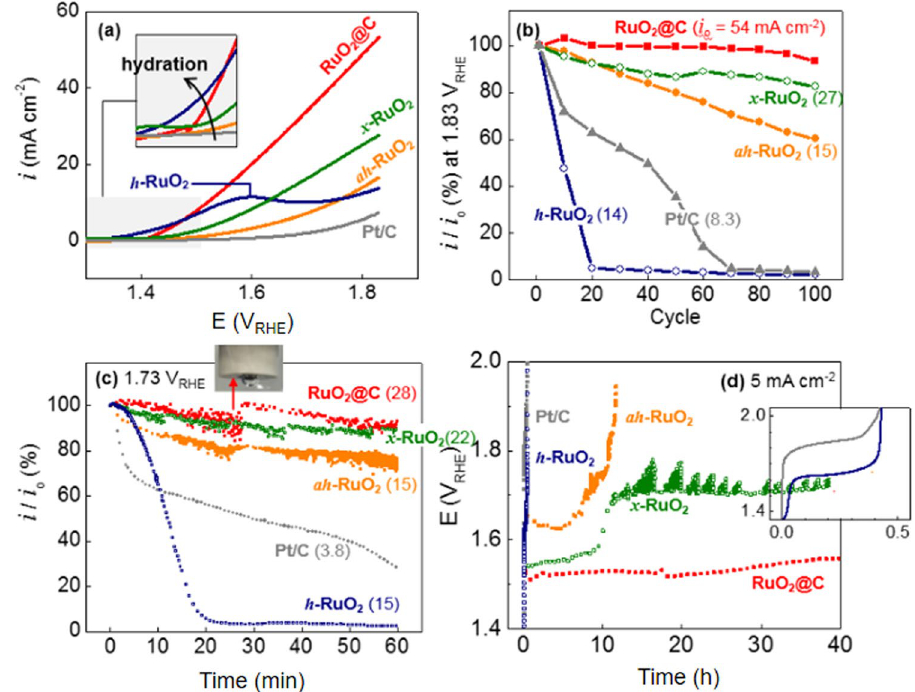
Figure 4. OER in N 2 -saturated 0.1 M KOH (aq). ( a ) OER polarization curves at 1,600 rpm for the first potential sweep cycles at 10 mV s − 1 . ( b ) OER current retention at 1.83 V RHE during repeated cyclic voltammograms. ( c ) Chronoamperometric stability of OER at 1.73 V RHE for 60 min in 0.1 M KOH. The initial currents are indicated next to the names of the catalysts. ( d ) Chronopotentiometric stability of OER at 5 mA cm − 2 for 40